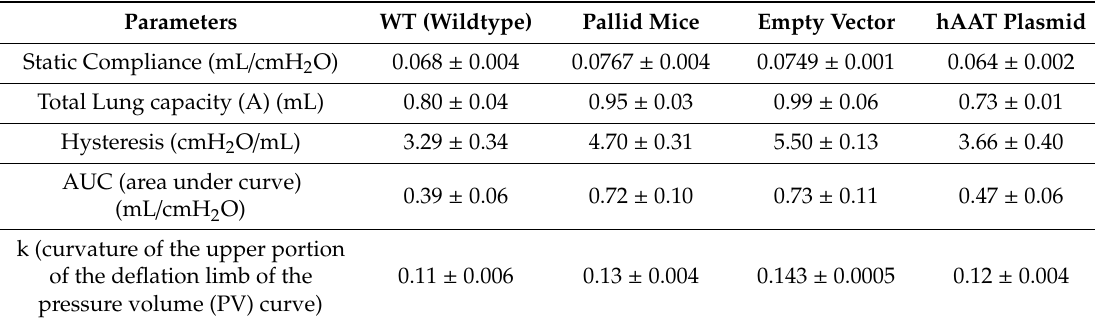
AUC (area under curve) (mL / cmH 2 O) k (curvature of the upper portion of the deflation limb of the pressure volume (PV)